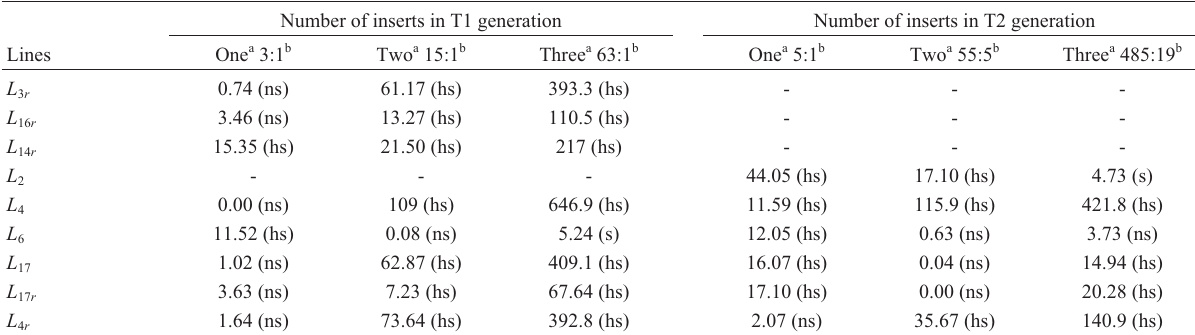
Table 5 - (cid:3) 2 test results for transgene segregation in the T1 and T2 generations. Number of inserts in T1 generation